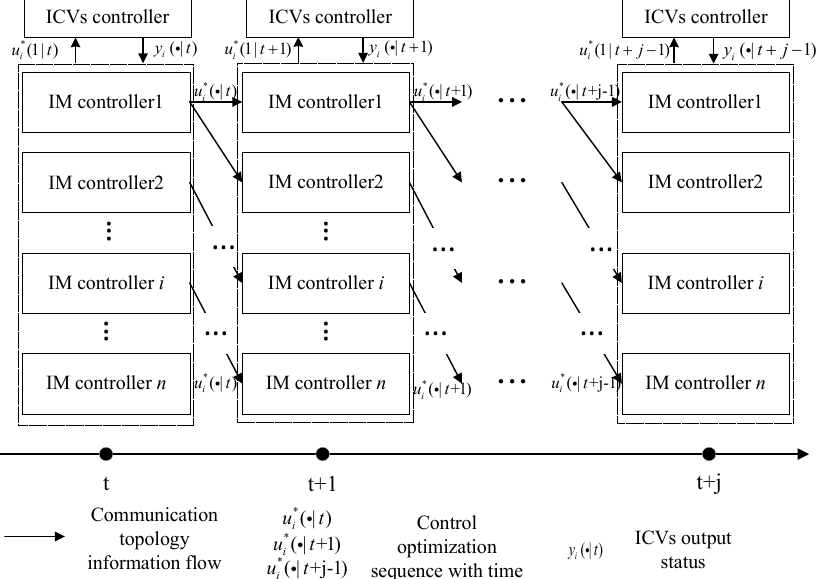
Figure 4. Flowchart of the DMPC algorithm.